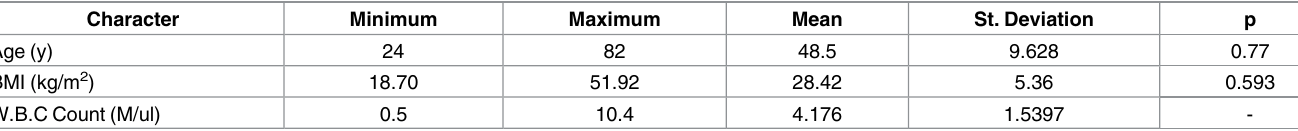
Table 2. Demographic characteristics of the cohorts.